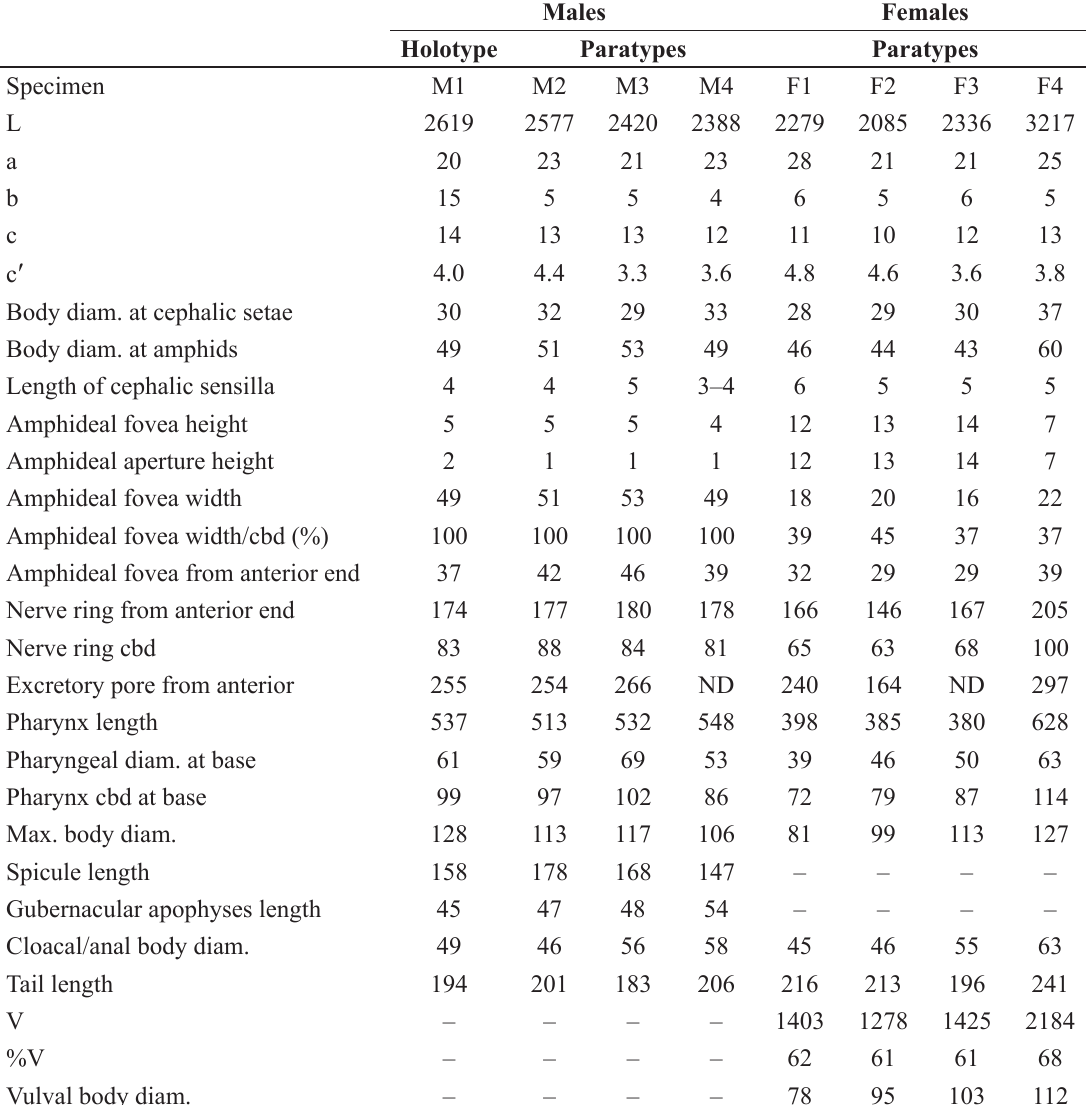
Table 5. Morphometrics (µm) of Deraionema barbatum gen. et sp. nov. Abbreviations: a = body length/ maximum body diameter; b = body length/pharynx length; c = body length/tail length; cʹ = tail length/ anal or cloacal body diameter; cbd = corresponding body diameter; L = total body length; V = vulva distance from anterior end of body; %V = V/total body length ×